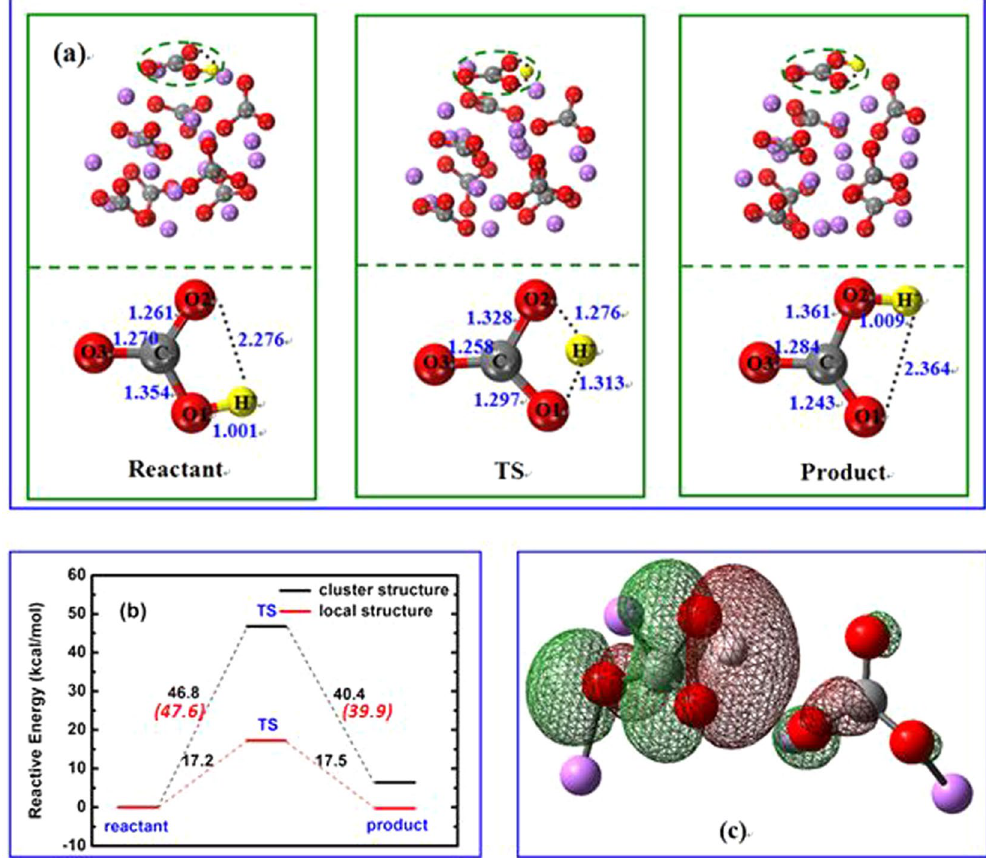
Figure 1. ( a ) Structures of reactant, transition state (TS) and product, the upper panel is the whole cluster, while local structure only for the lower panel; ( b ) Relative energy for proton migration inside of a carbonate ion calculated by the whole cluster and local structure, respectively; ( c ) Selected molecular orbital in TS for bonding between proton and carbonate. The proton, carbon, oxygen and lithium atoms are shown as yellow, gray, red, and purple respectively. (Distance in Å and relative energy in